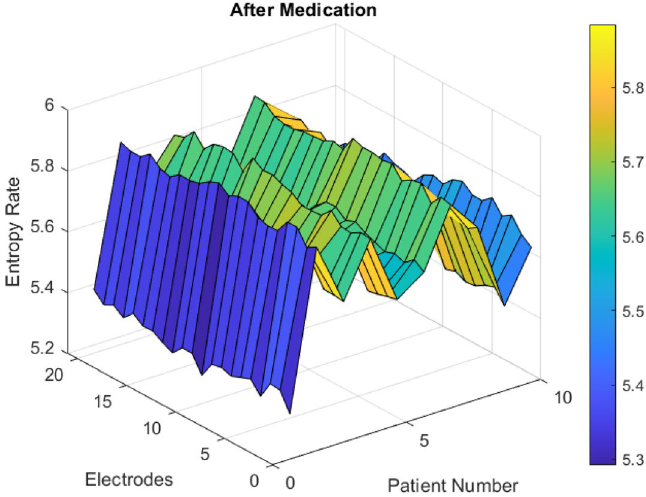
Figure 8. Post- intake, (∆E) Entropy Rate is low in bipolar patients, disordered over electrodes.